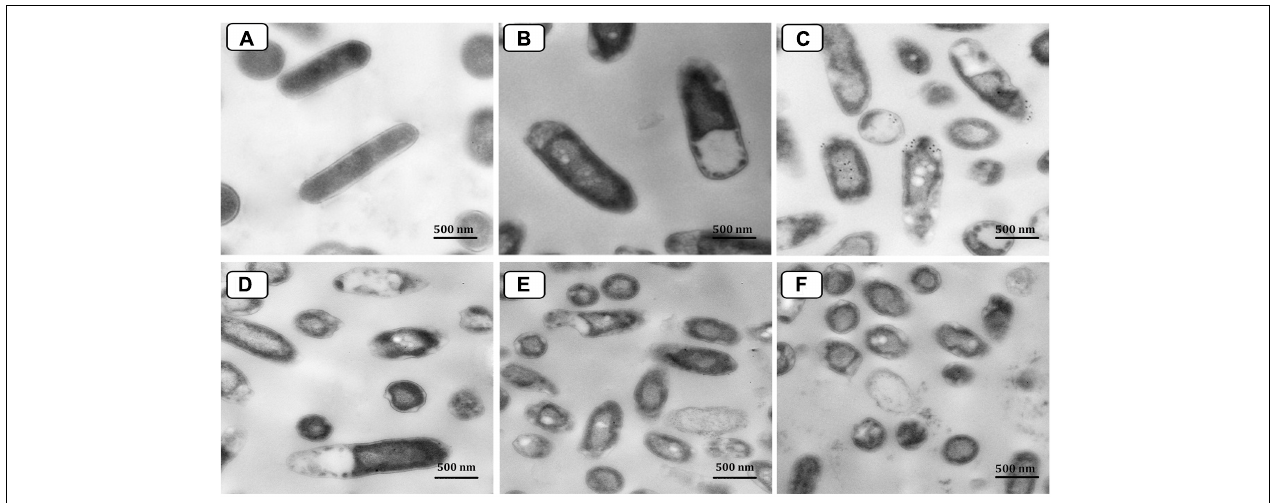
FIGURE 11 | Transmission electron micrograph of P. aeruginosa P 8 cells under different treatments. Untreated cells (A) . Cells treated with neomycin only (B) . Cells treated with Ag-NPs only (C) . Cells treated with neomycin-Ag-NPs combination (D–F)